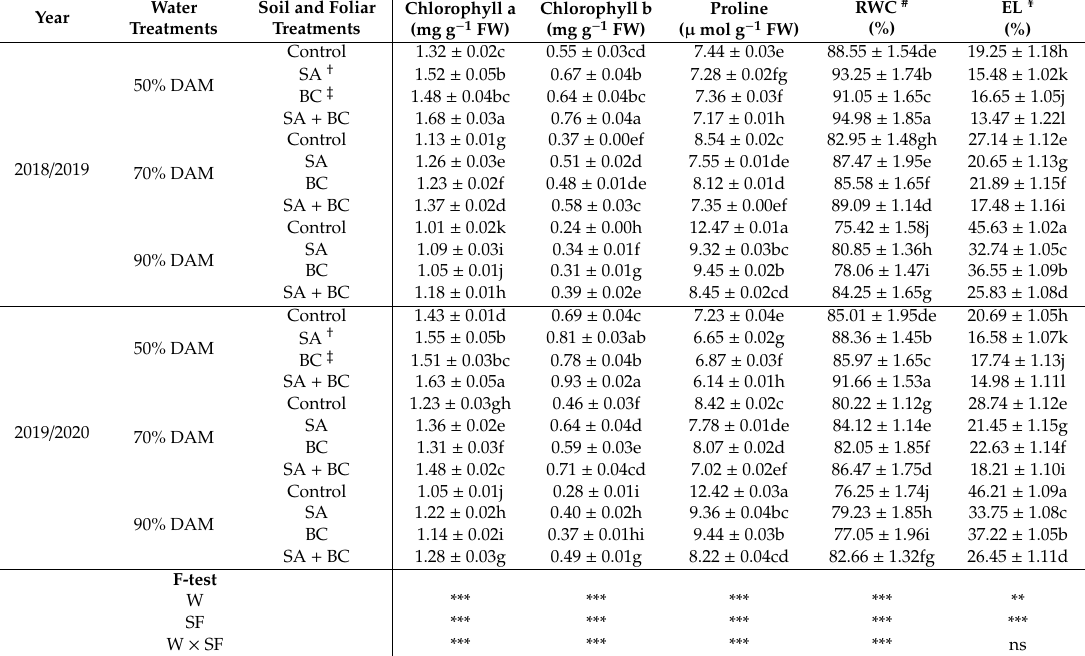
Table 3. Physiological properties of wheat plants irrigated with (50%, 70%, and 90% DAM) in saline sodic soil treated by salicylic acid and biochar during two growing